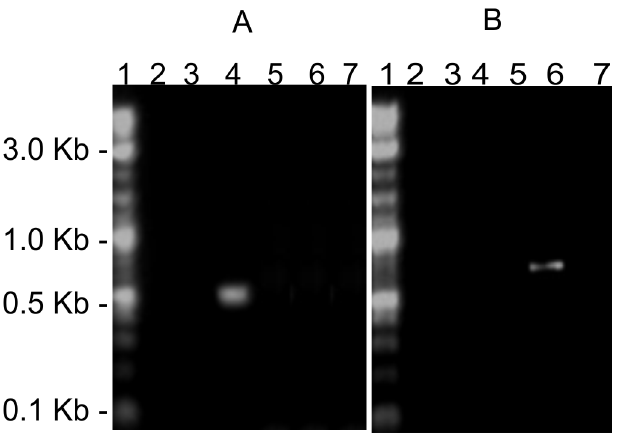
Fig 3. Expression of Rv3724 and its homolog Mb_3751 in Mtb H37Rv and M . bovis BCG respectively.